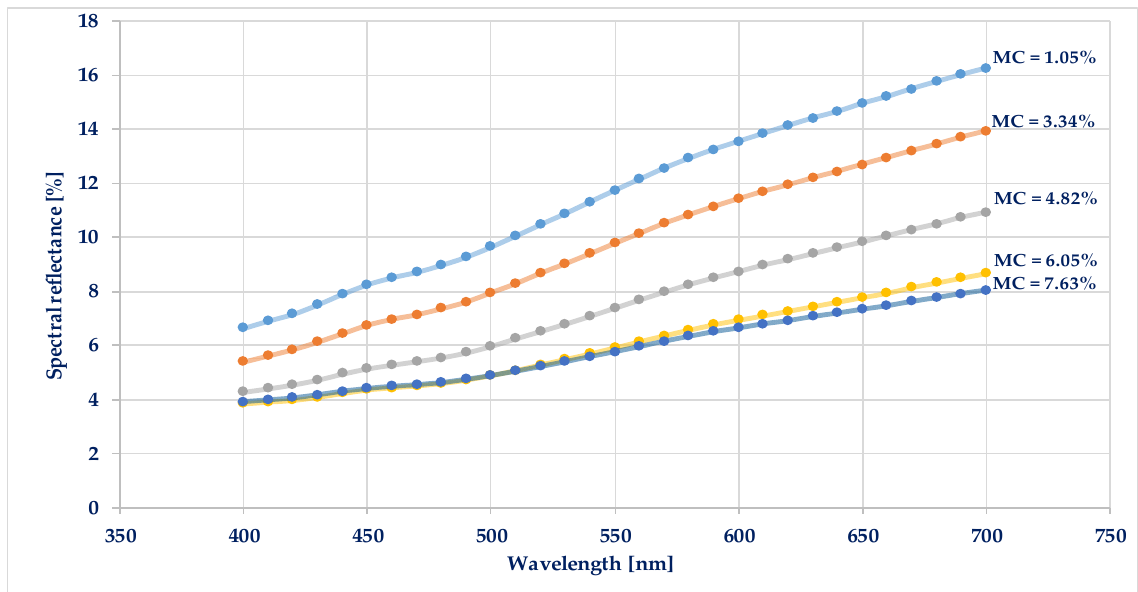
Figure 5. Soil spectral reflectance (spectral behavior) to the wavelength sent from the spectropho- tometer at different moisture contents.